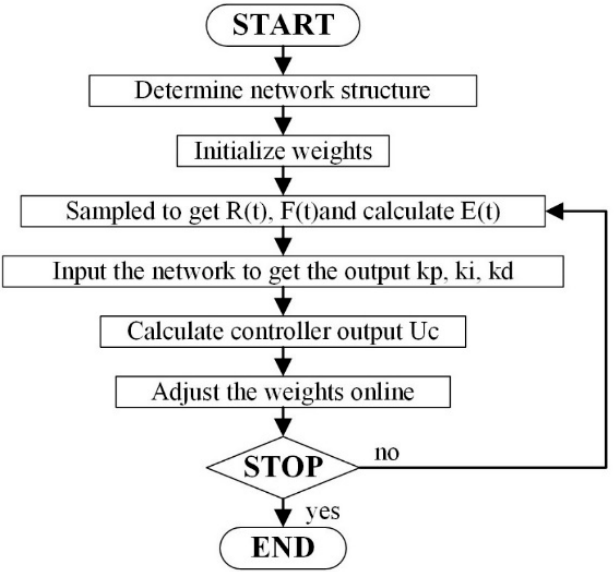
Figure 8. ANN1 training flowchart.